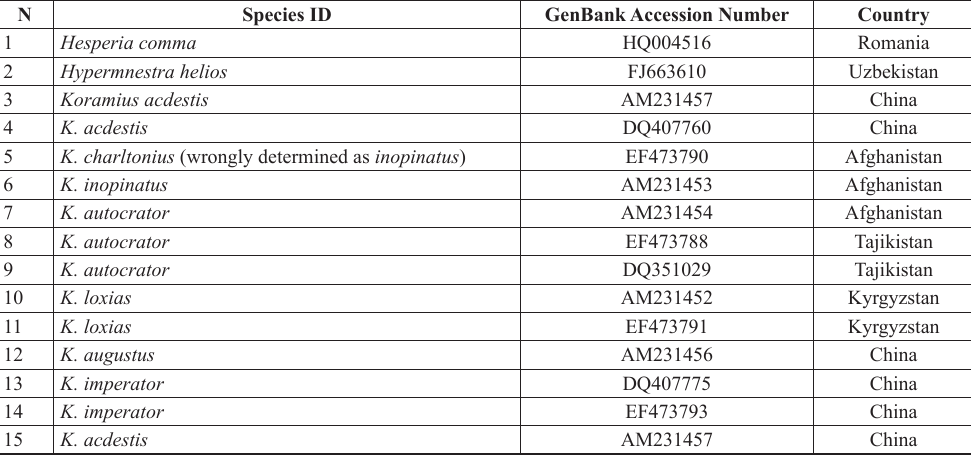
Table 4. Samples of other Koramius and other outgroup species from GenBank used in this